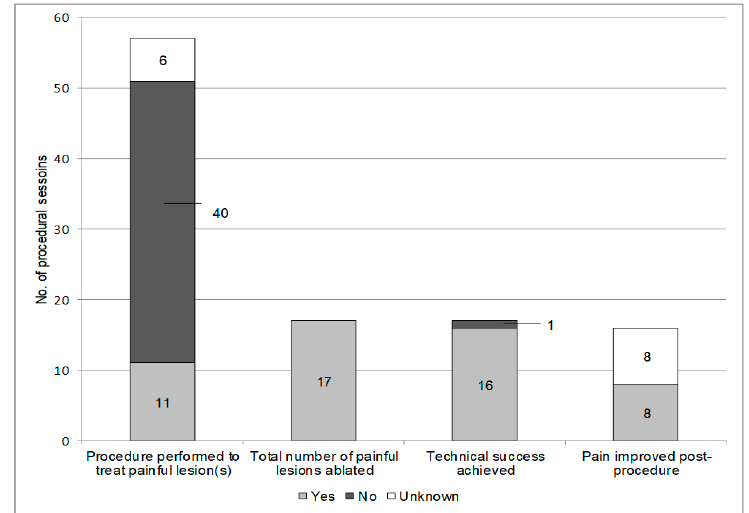
Figure 2. Outcomes of ablations performed to treat pain in patients with metastatic pheochromocytoma and paraganglioma. Eleven procedures were performed to treat a total of 17 painful metastases. Technical success was achieved for 16 of the ablated metastases. Of those lesions, all eight patients with symptom follow-up post procedure had improvement in